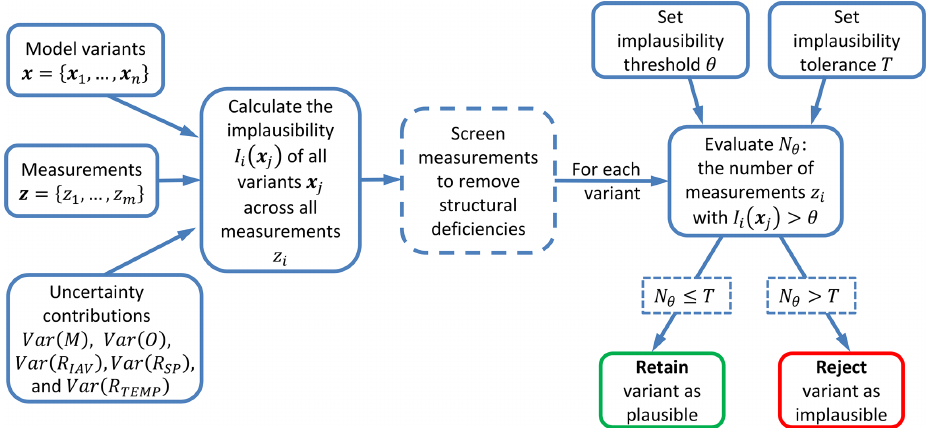
Figure 3. Flowchart detailing the process followed for each model variant x j , in using the calculated implausibility over a set of m measure- ments z = { z 1 ,z 2 , ··· ,z m } (for a single output variable y ) simultaneously to constrain the model uncertainty.